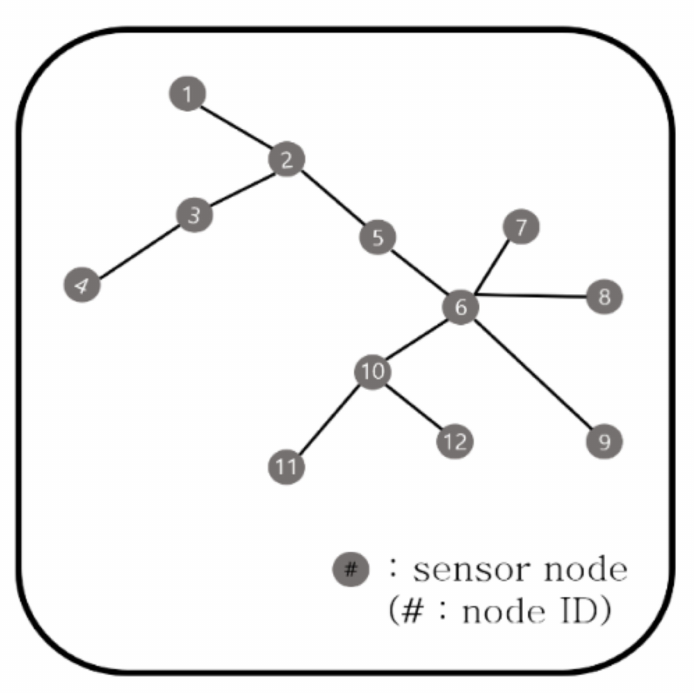
Figure 3. Generated tree from the subgraph after Step